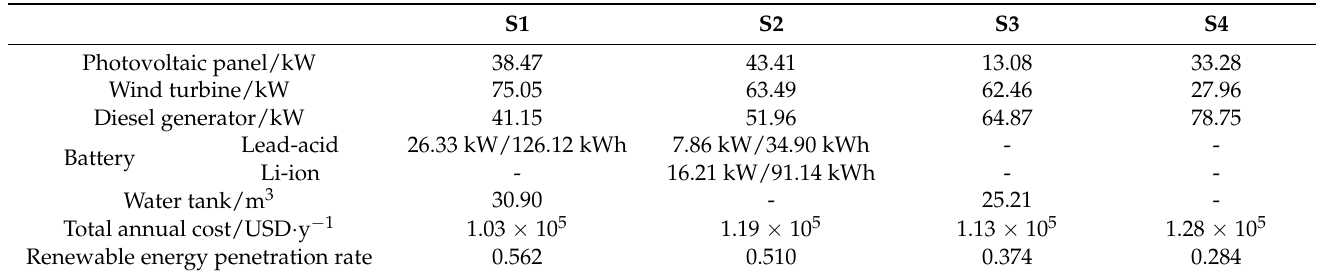
Table 3. Optimal results under different